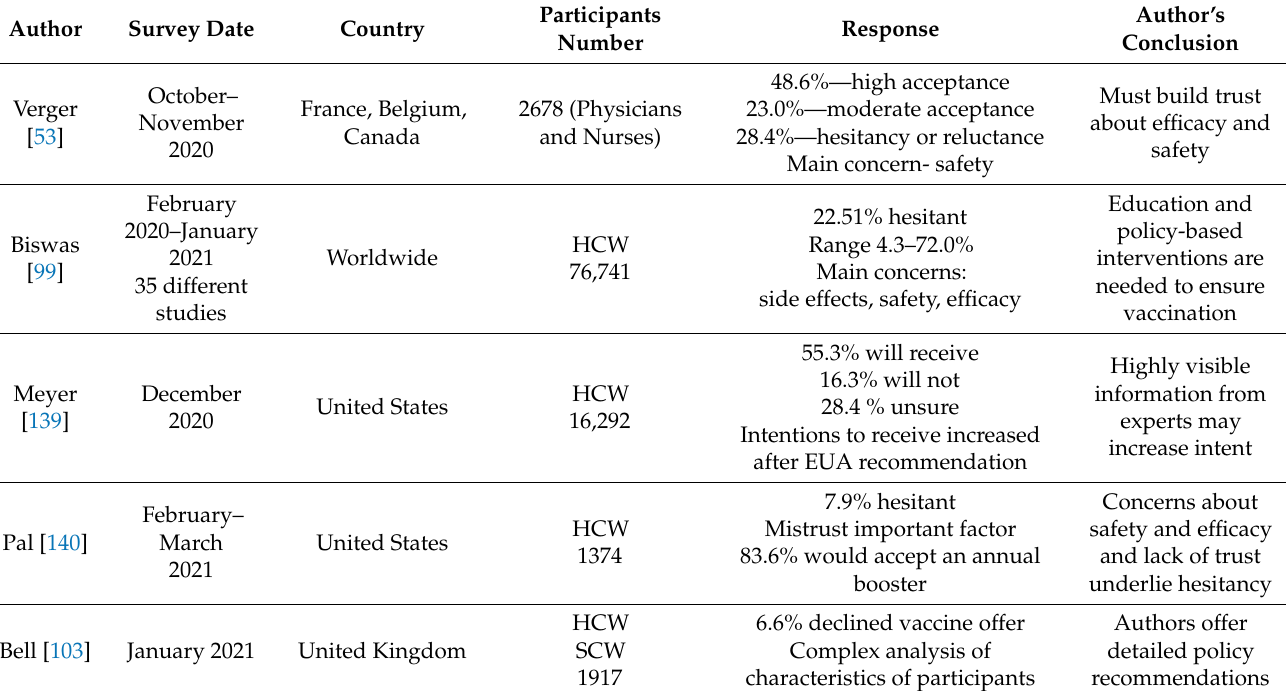
Table 1. Representative surveys analyzing vaccine